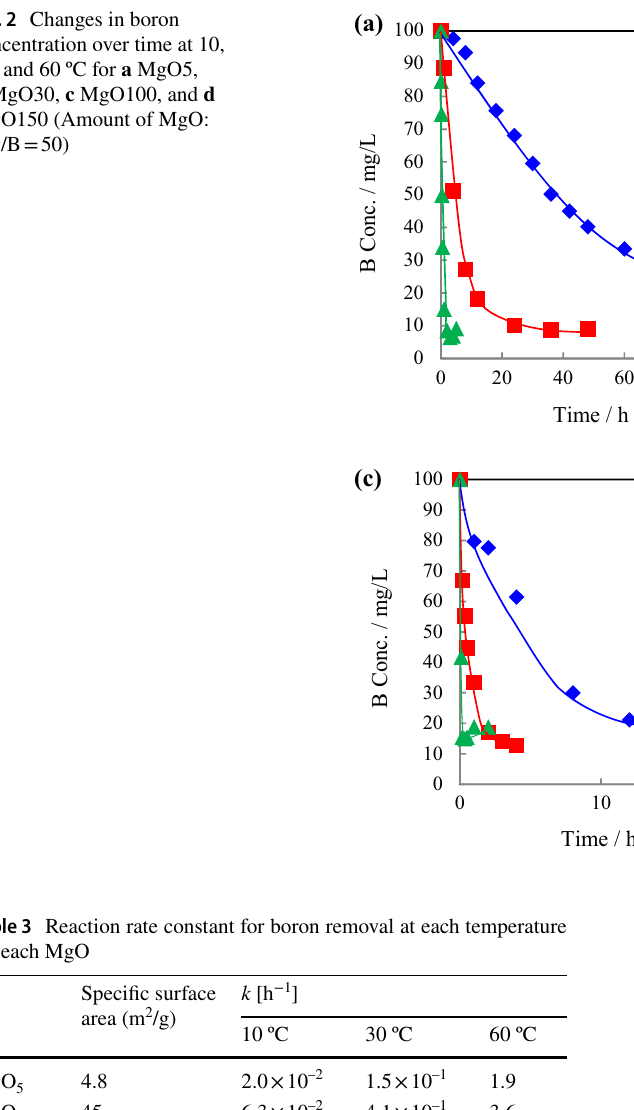
Fig. 2 Changes in boron concentration over time at 10, 30, and 60 ºC for a MgO5, b MgO30, c MgO100, and d MgO150 (Amount of MgO: Mg/B = 50)